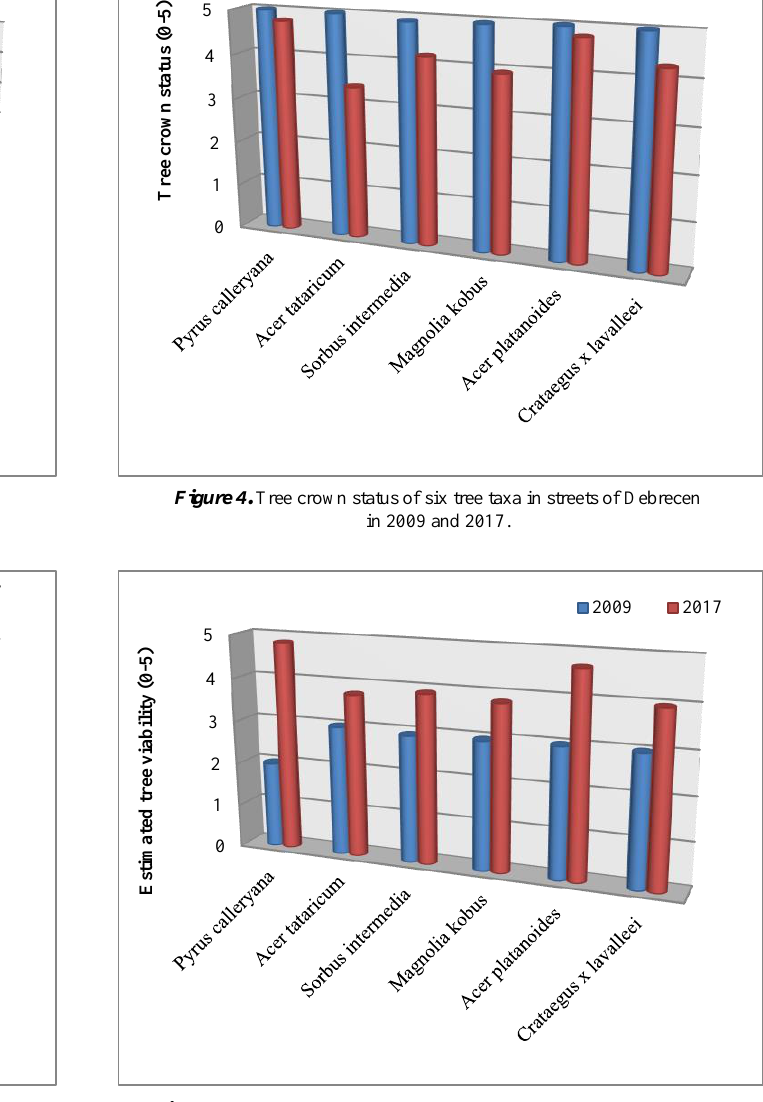
Figure 2. Tree crown diameter of six tree taxa in streets of Debrecen in 2009 and 2017.